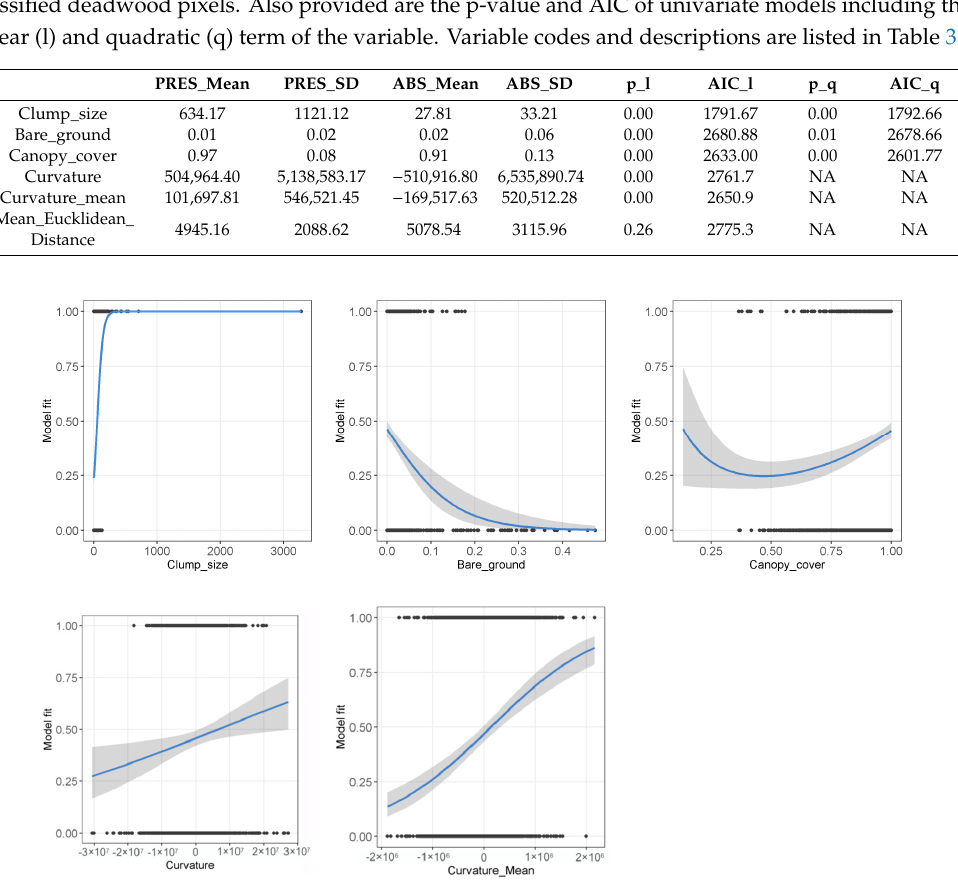
Figure A2. Effect plots showing probability of a deadwood-pixel to be correctly classified as “dead” as a function of the predictor variables included in the deadwood-uncertainty model (Table A2). The blue line indicates the estimated smoothing parameter of a given variable, while keeping all other variables set to their median value. Shadowed areas indicate the 95% confidence intervals conditional on the estimated smoothing parameter. Variable codes and descriptions are listed in Table 3.